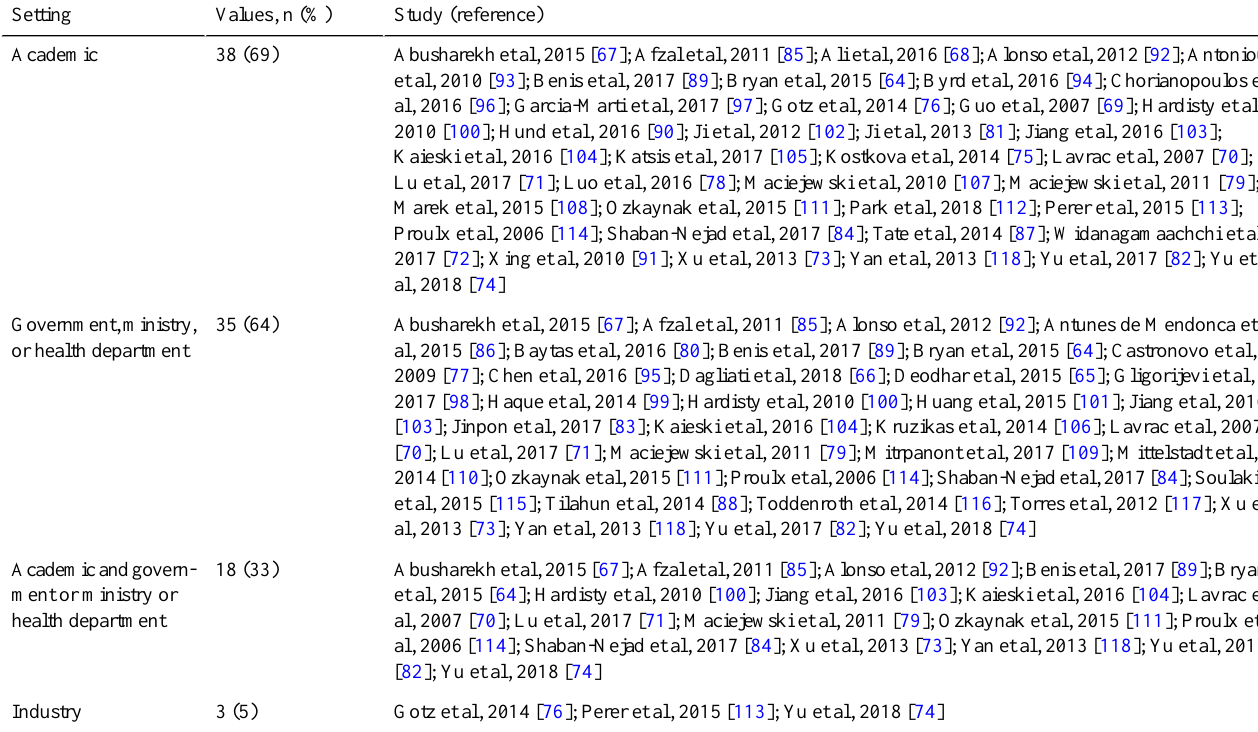
Table 2. Setting of the use